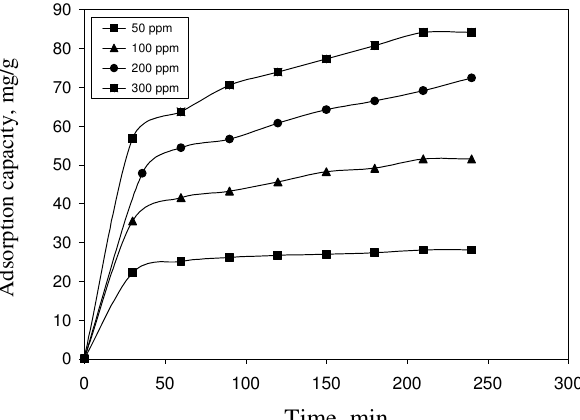
Figure 4 . Effect of contact time on adsorption of Cr(VI) on trametes versicolor polyporous fungi.